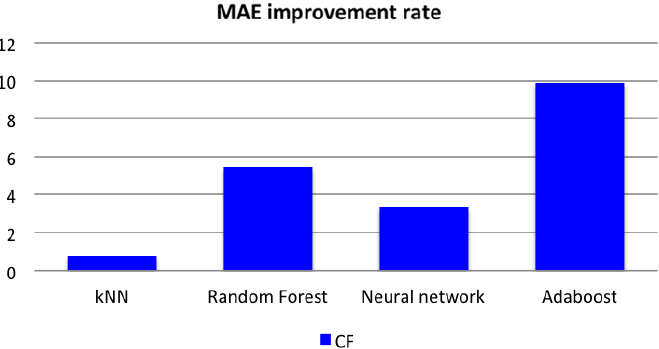
Fig. 8. MAE improvement rate.